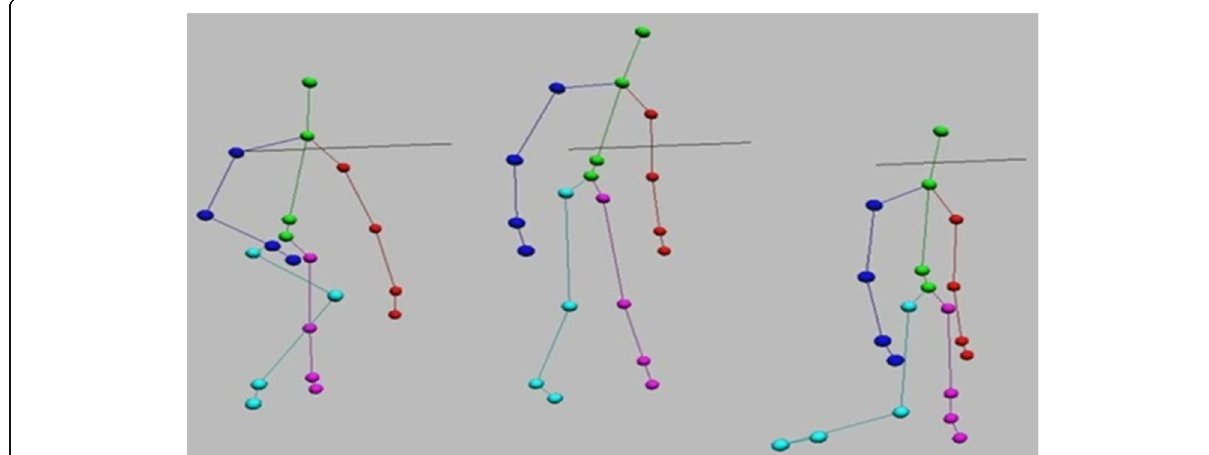
Fig. 5 Examples of key poses retained for the Kneel category